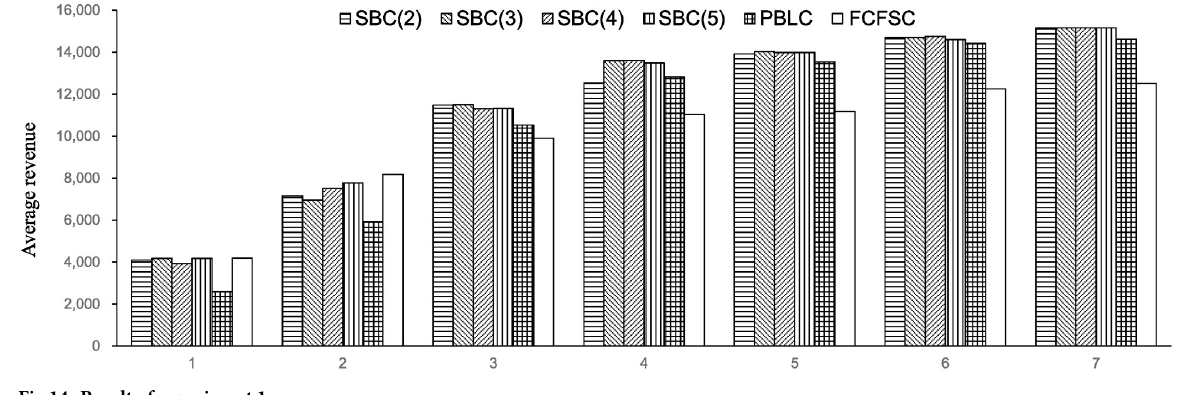
Fig 14. Result of experiment 1.